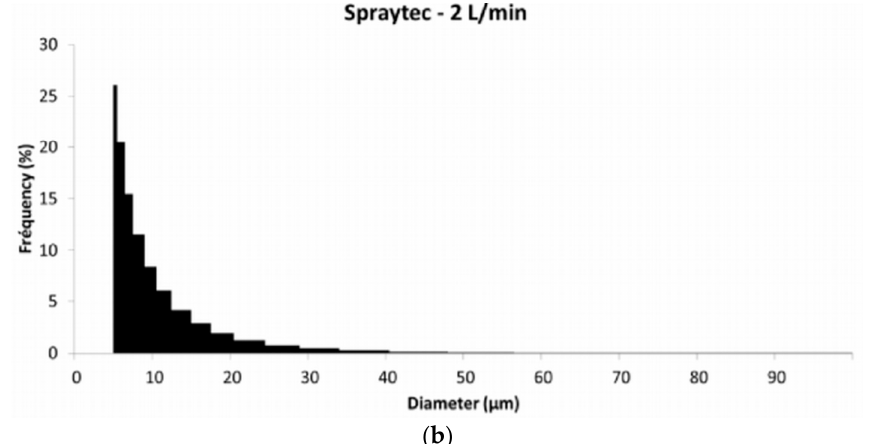
Figure 6. ( a ) Count of coupling energy drops during the test of water particles with our device. Coupling energy drops smaller than 5% are considered noise and excluded from the count; ( b ) Particle size distribution in a nebulizer’s output measured with Malvern’s Spraytec particle counter [18].